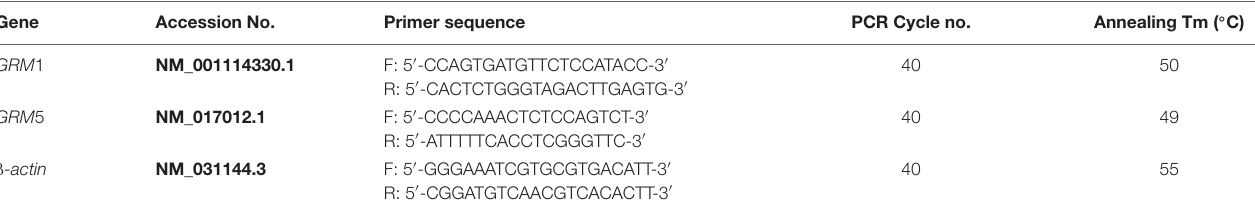
TABLE 2 | Sequence of rat primers used in RT-PCR experiment.